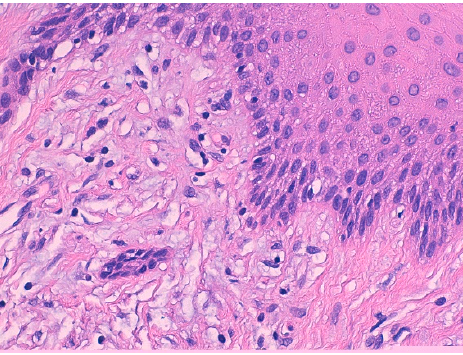
Figure 7. Histological findings of the biopsied sample: the subepithelial deposition of dense hypocellular connective tissue collagenized with focal mixoidal changes.